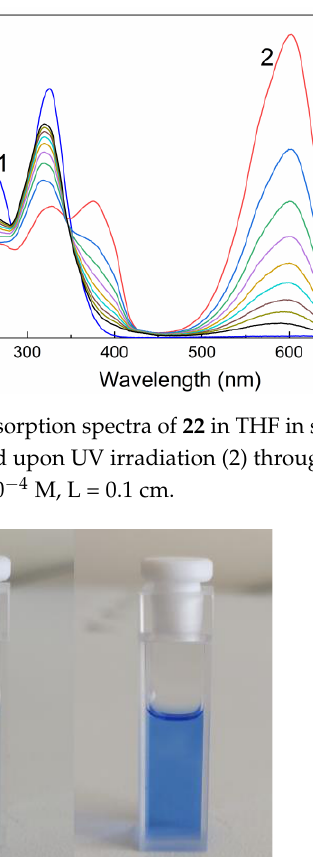
Figure 2. Photo of solutions of compound 22 in THF before (left) and after irradiation (right). Upon UV irradiation, the intensities of bands at 266 – 267 and 324 – 327 nm somewhat decrease, while the intensities of the 374 – 377 and 599 – 604 nm bands considerably increase (Figure 1, spectra 2 – 10). These changes unambiguously indicate that UV irradiation induces photochromic transformations of spiropyrans in the adsorption layer to give the open merocyanine form of the molecules. The observed changes are reversible: molecules 22 – 26 cyclize again in the dark (dark bleaching) or under the action of visible light (photobleaching). This switching cycle can be repeated more than 10 times. The complete photoinduced transition of spiropyrans 22 – 26 (10 − 4 M in THF) from closed to open form takes 11–18 s. The reverse transition is characterized by a longer duration: 180–190 s with dark discoloration, and 100–170 s with visible light